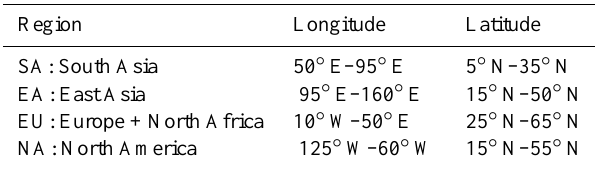
Table 1. Definition of four regions in the Northern Hemisphere for the HTAP-study